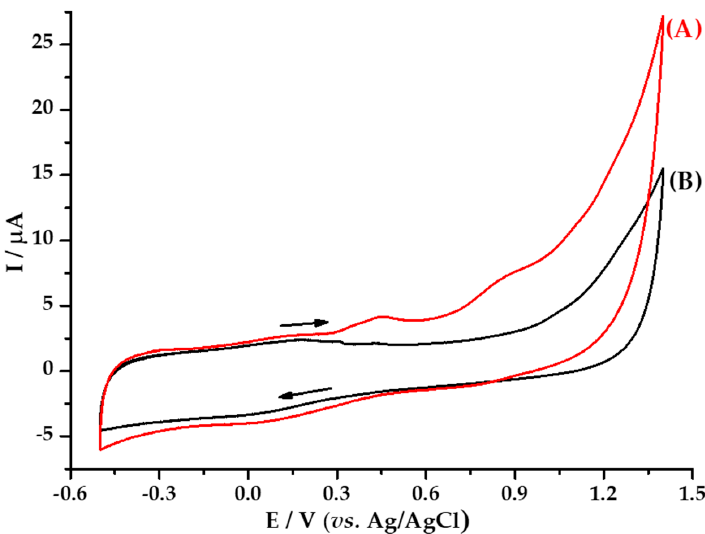
Figure 7. Cyclic voltammograms of: ( A ) M. albida extract in 0.10 mol L − 1 sodium acetate solution, ( B ) blank acetate solution; on glassy carbon (GC) work electrode. Scanning rate 50 mV/s vs. Ag/AgCl at 25 °C.